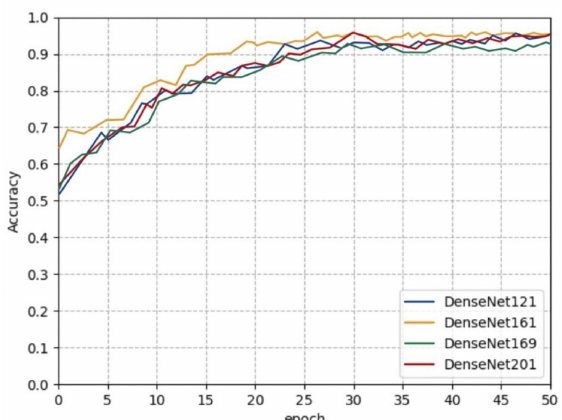
Figure 14. Experiment results of DenseNet